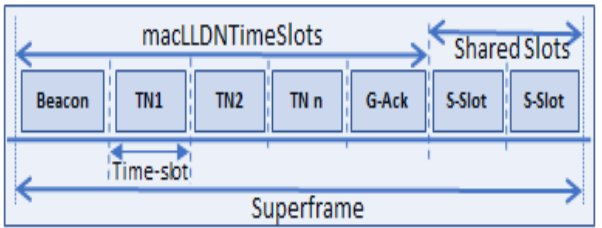
Figure 1. IEEE 802.15.4e Communication Frame structure with Group acknowledgement and shared